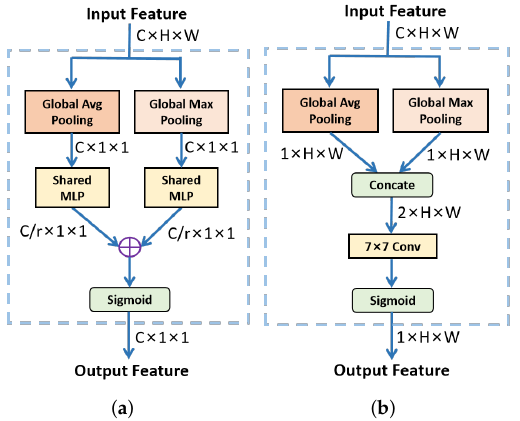
Figure 5. The detailed architectures of CA and SA in STAM. ( a ) Channel Attention (CA). ( b ) Spatial Attention